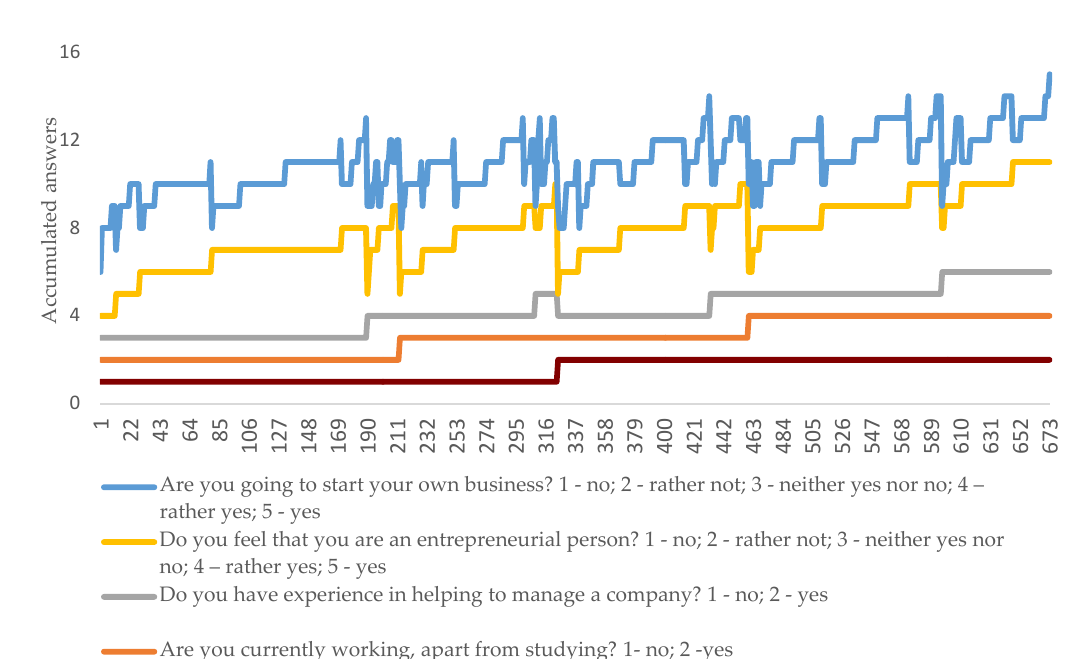
Figure 1. The accumulated answers of the respondents in terms of several questions of the questionnaire.